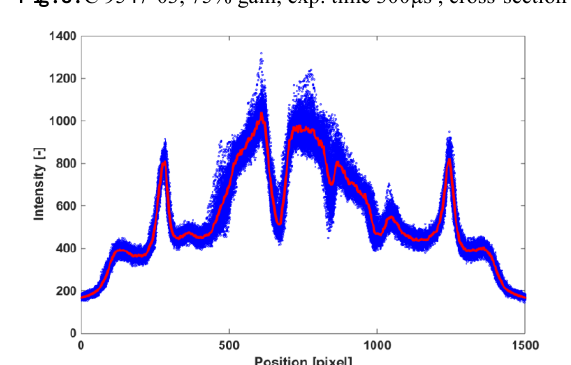
Fig. 7. C 9547-03, 75% gain, exposure time 300µs